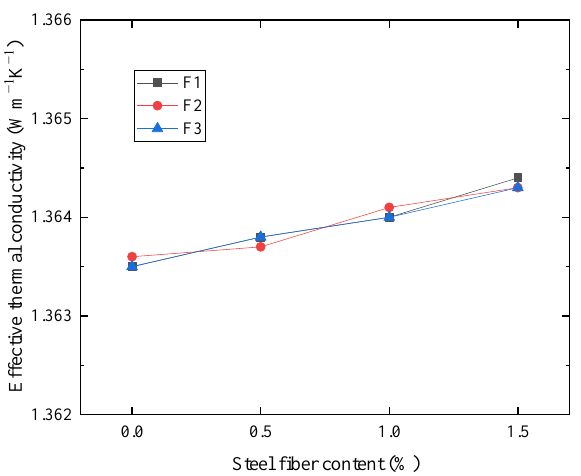
Figure 16. Effect of the steel fiber orientation.